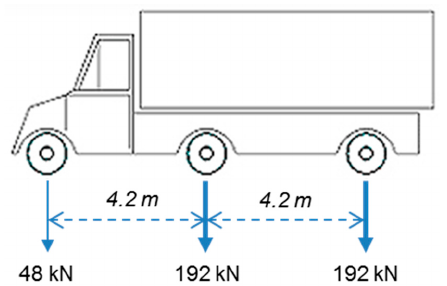
Figure 6. Vehicle load model (DB-24) of the Korea Highway Bridge Design Specification (KHBDS).